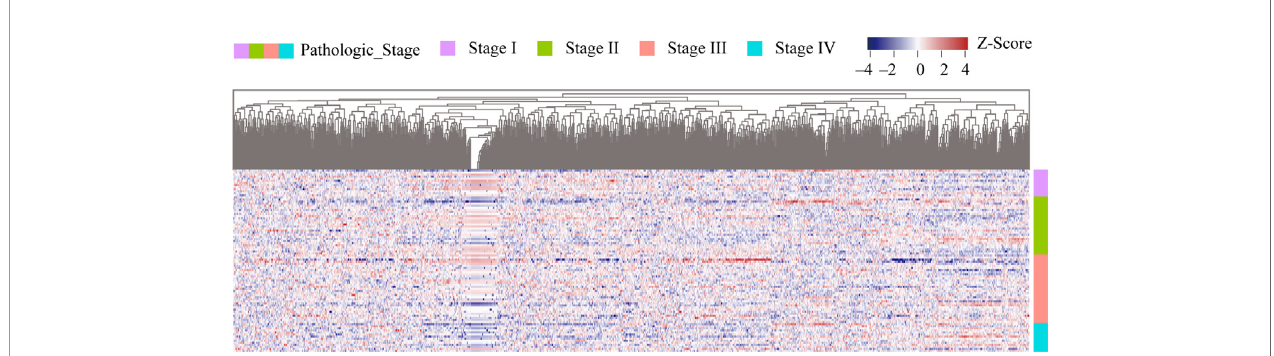
FIGURE 2 | Heatmap of m 6 A candidate gene expression in READ samples among four stages. The samples were sorted by stages from low to high, from I to IV. Stage I samples were represented by the purple group in the right, stage II, III and IV samples by green, red, and blue groups respectively. Genes were sequenced from small to large top-down according to the P value of differential expression analysis results. Red represents high expression of genes, purple represents low expression of genes, and the intensity of the color is directly proportional to the difference of genes.